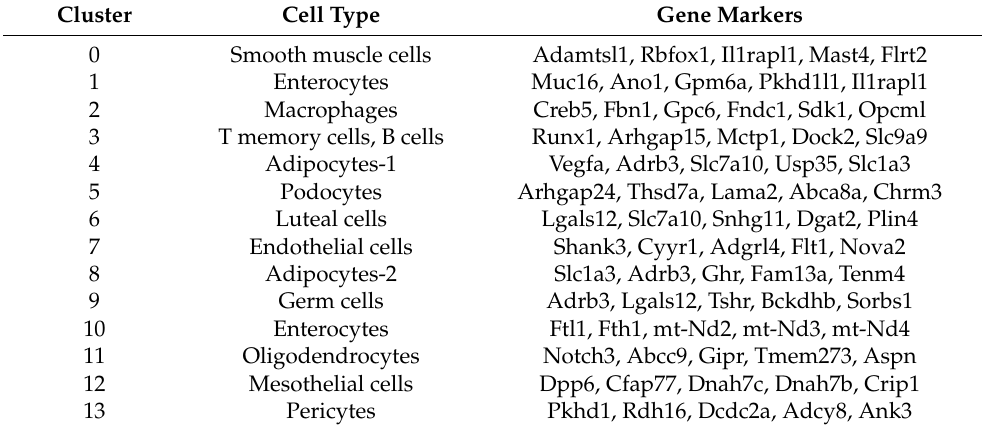
Table 2. Cell types with their top 5 gene markers for vWAT in mice as determined from the combined data for mice exposed to IH or